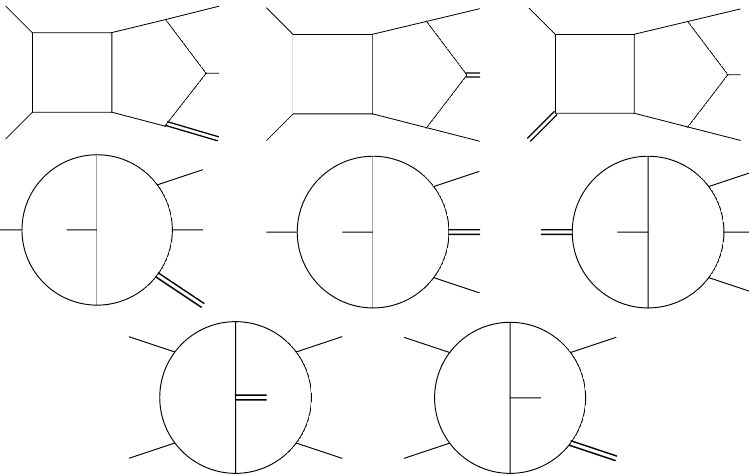
Figure 1 . Diagrammatic representation of the planar and non-planar families with one external massive leg (double line). In the first row, P 1 (left), P 2 (middle) and P 3 (right) planar families are shown. In the second and third row, N 1 (top left), N 2 (top middle), N 3 (top right), N 4 (bottom left), N 5 (bottom right) non-planar families are shown. All internal particles are